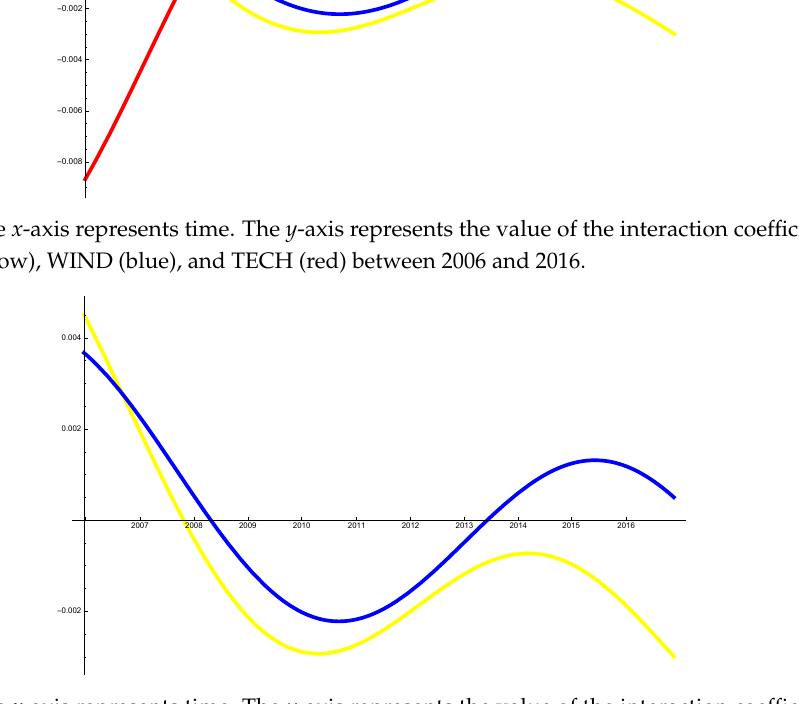
Figure 7. The x -axis represents time. The y -axis represents the value of the interaction coefficients of SOLAR (yellow) and WIND (blue) between 2006 and 2016.